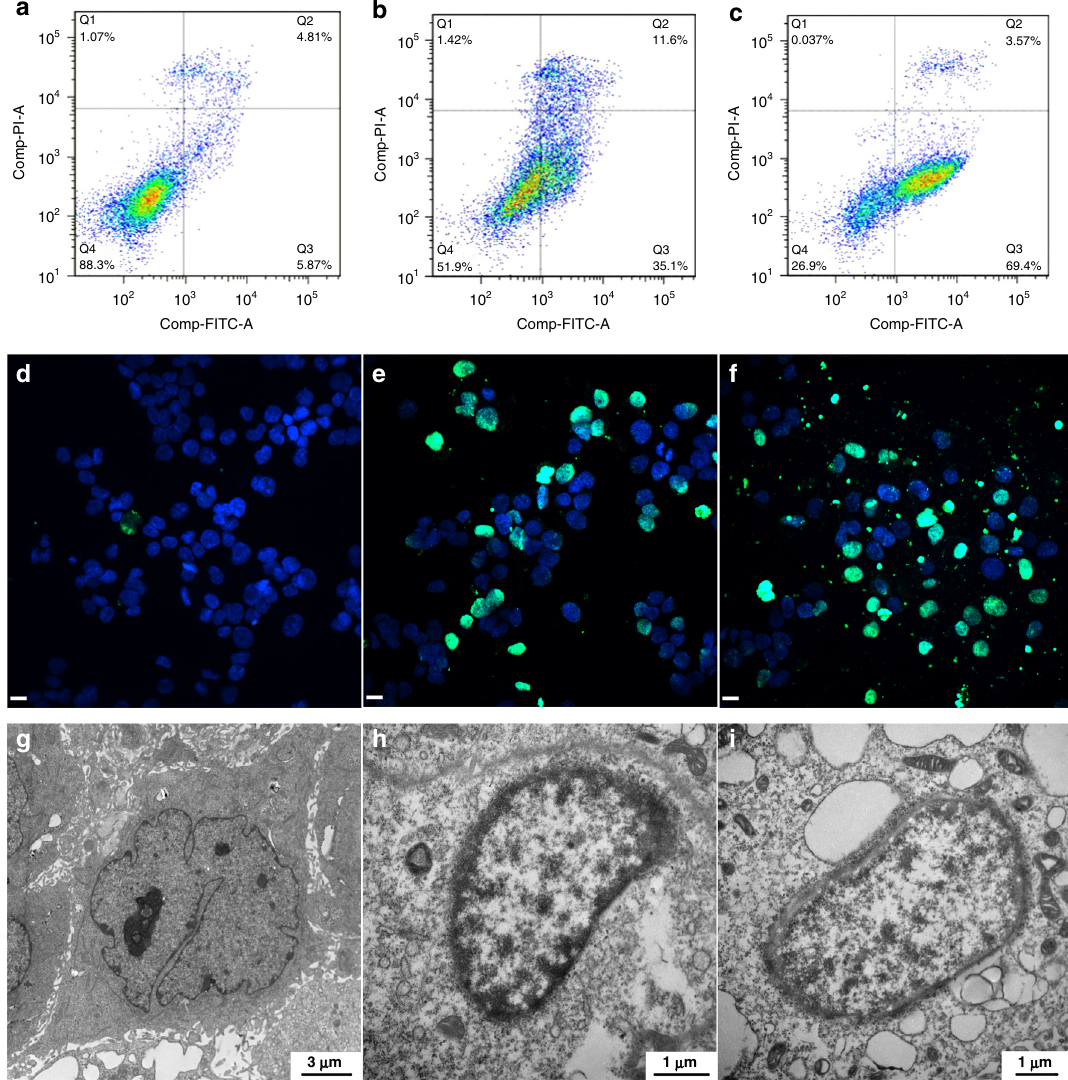
Fig. 3 Con fi rmation of cell apoptosis. Contour diagram of Annexin V-FITC/PI fl ow cytometry results of MCF-7 cells incubated for 48 h. a Cells treated with PBS were used as a negative control; b cells treated with 25 μ M P1P5A; c cells treated with 50 μ M P1P5A. TUNEL analysis of MCF-7 cells incubated for 48 h. The apoptotic cells were labeled with FITC, while the nuclei were stained with DAPI; d cells treated with PBS were used as a negative control; e cells treated with 25 μ M P1P5A; f cells treated with 50 μ M P1P5A (scale bar: 24 μ m). TEM images of ultrathin sections of MCF-7 cells incubated for 48 h; g cells treated with PBS were used as a negative control; h the cells treated with 25 μ M P1P5A showed condensed chromatin and disappeared organelles; i the cells treated with 50 μ M P1P5A showed the formation of many blebs and swollen or hollow